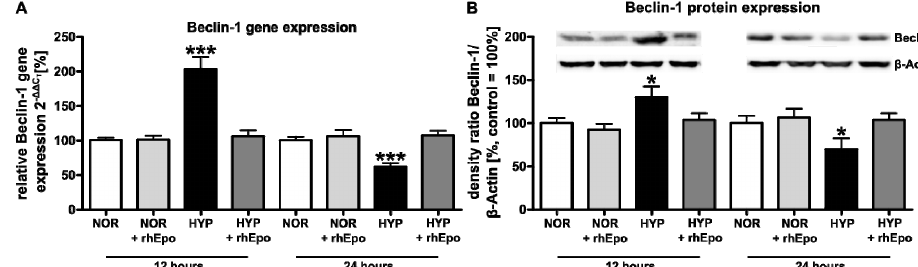
( A ) Quantitative analysis of Beclin-1 mRNA expression by real-time polymerase chain reaction (PCR) after 12 or 24 h of hyperoxia with or without rhEpo treatment. ( B ) Beclin-1 protein expression after 12 or 24 h of hyperoxia with or without rhEpo treatment; the densitometric data represent the ratio of the pixel intensity of the Beclin-1 band to the corresponding β -actin band. Blots are representative of a series of three blots. White bar normoxic control (NOR); light grey bar normoxic control + rhEpo; black bar hyperoxia (HYP); dark grey bar hyperoxia + rhEpo. Data are normalized to levels of rat pups exposed to normoxia (control 100%; bars represent mean + SEM, n = 8 per group, *** p < 0.001, * p < 0.05, independent t -test after one-way ANOVA, bonferroni corrected compared to respective